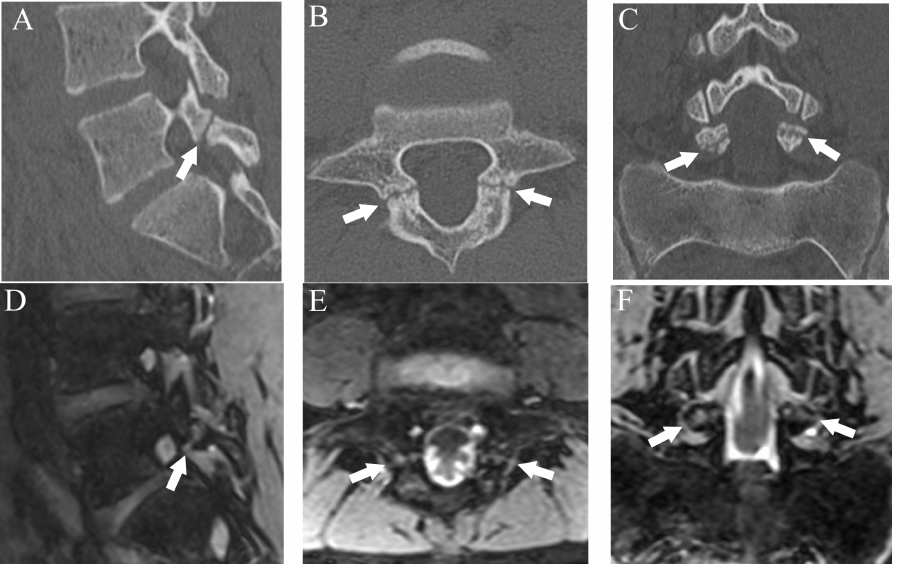
Figure 5. Comparison of bilateral grade 3 fractures at L5 from an 11-year-old male in multiple planes between CT and DESS. ( A – C ) CT shows complete fractures in L5 pars interarticularis on the right-sided sagittal, axial, and coronal plane, respectively (arrows). ( D – F ) DESS shows comparable complete fracture on the right-sided sagittal, axial, and coronal plane, respectively (arrows).